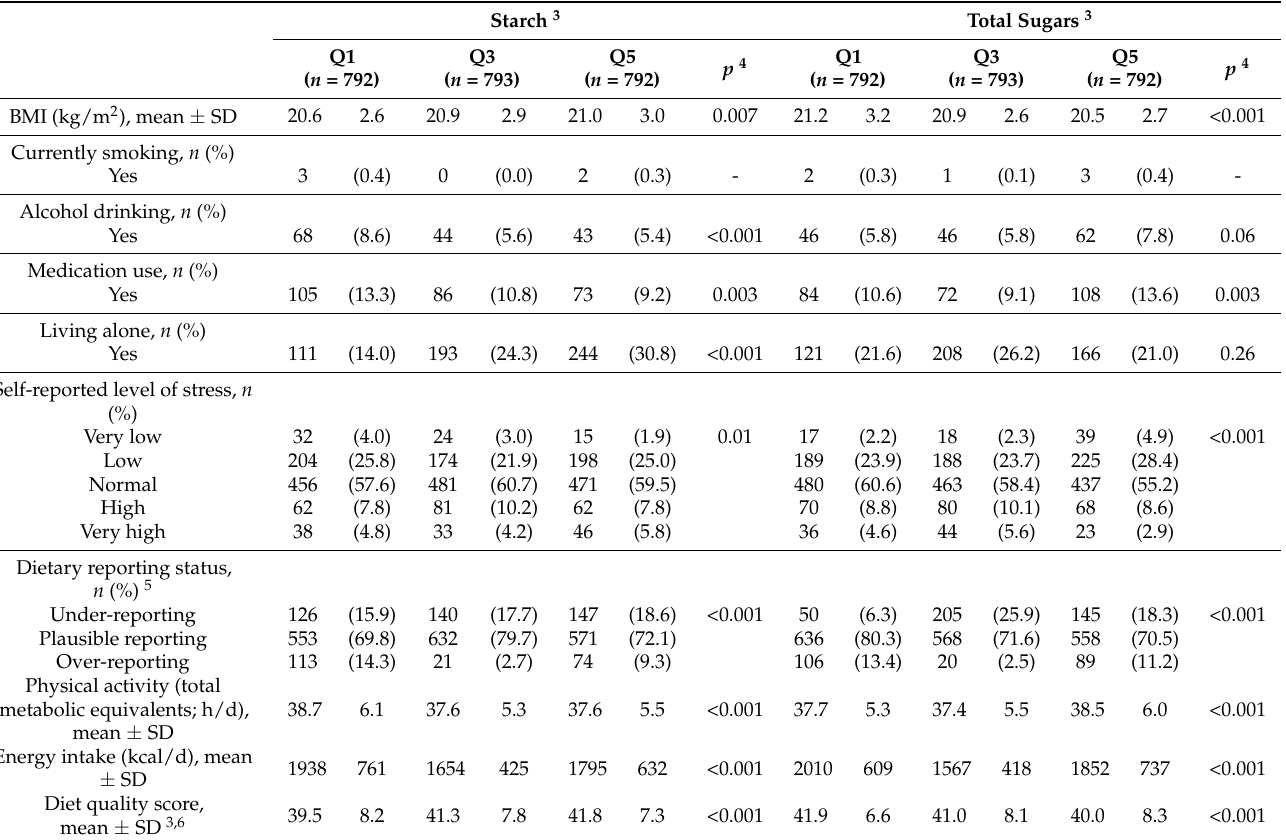
Table 3. Selected characteristics of 3963 young Japanese women according to the quintiles of the energy-adjusted intakes of starch and total sugars 1,2